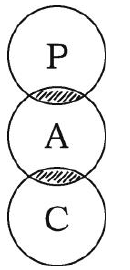
Figure 2: Ego state